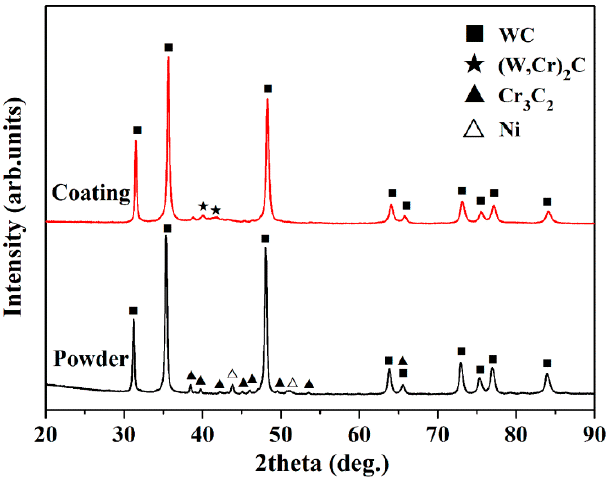
Figure 4. XRD patterns of the feedstock powder and the as-sprayed coating [37].